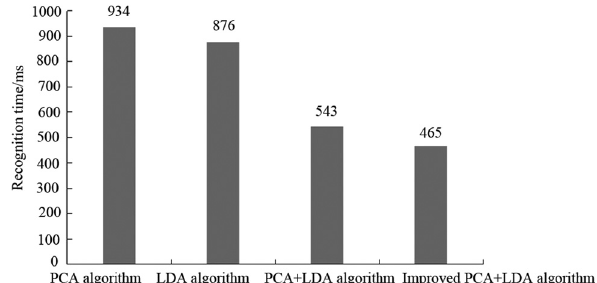
Figure 4: Comparison of recognition time between